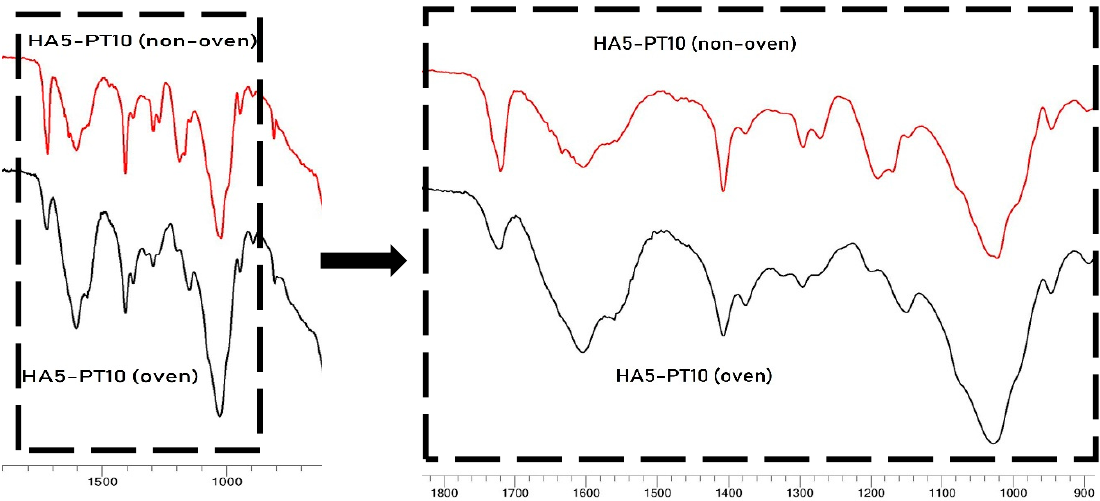
Figure 16. HA5-PT15 before and after crosslinking by the oven-assisted thermal method (x-axis is the wavenumber / cm − 1 ).